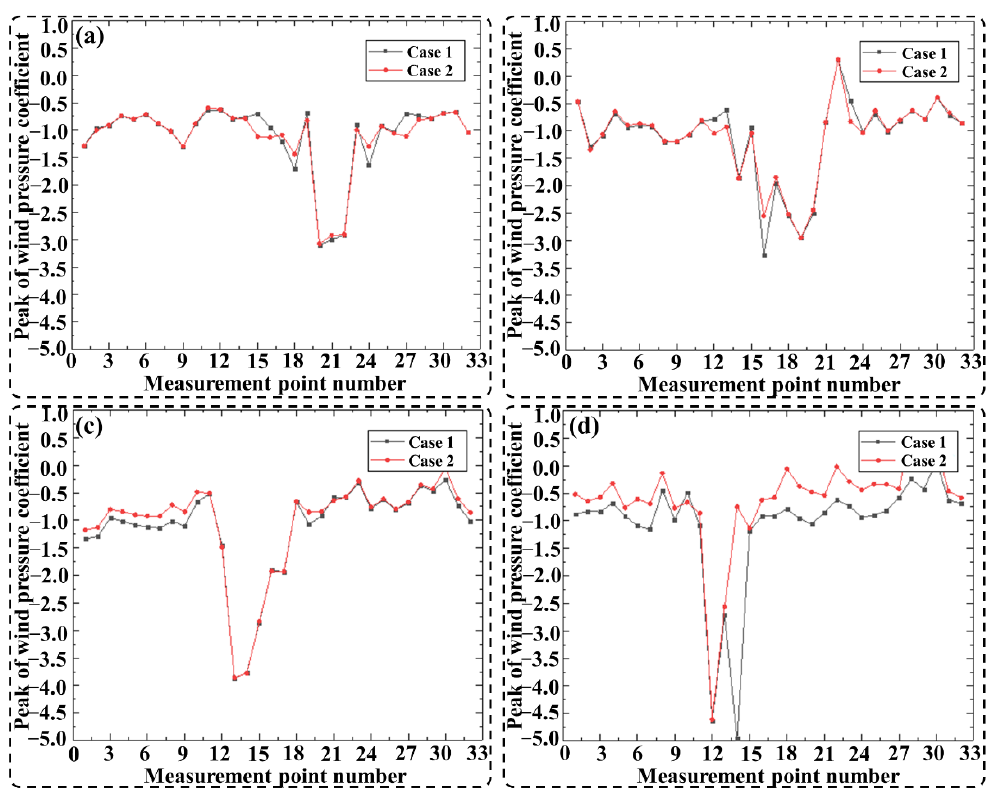
Figure 19. Maximum value of wind pressure coefficient of cross-section under each wind angle: ( a ) 0°; ( b ) 30°; ( c ) 60°; ( d ) 90°.